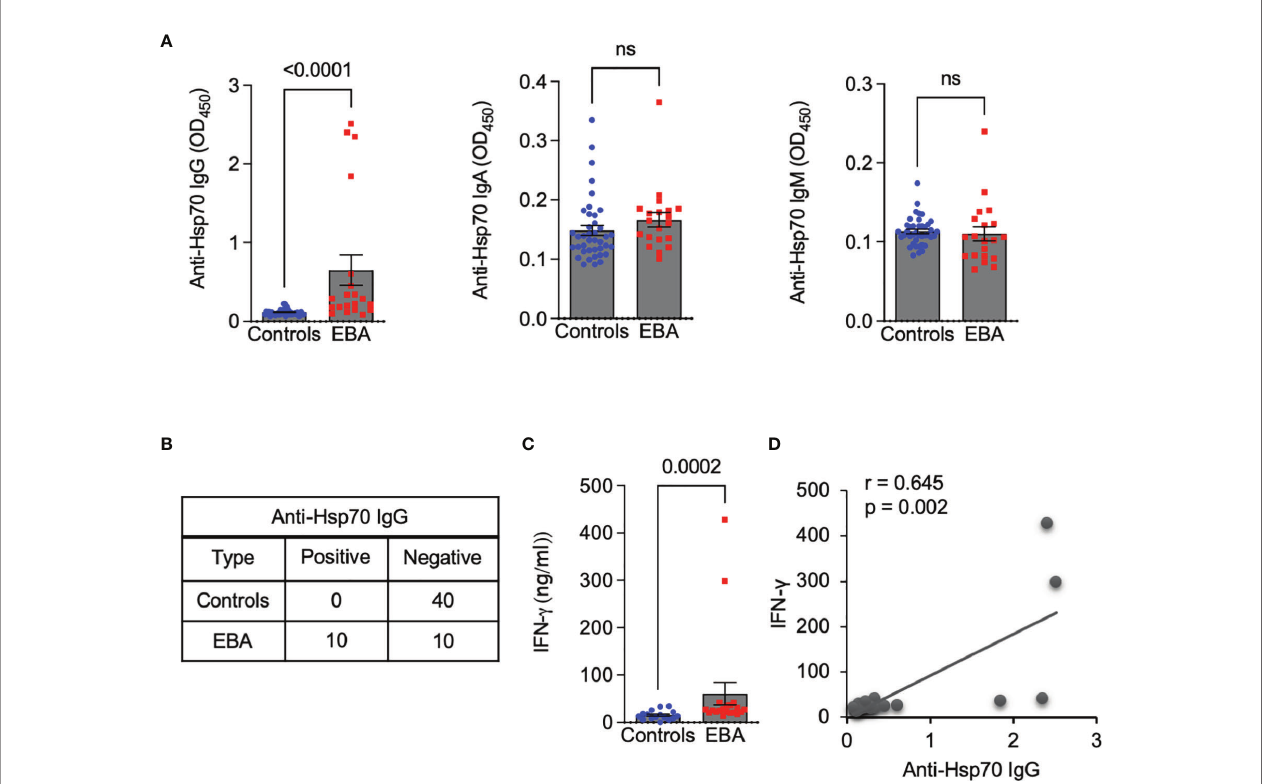
FIGURE 1 | Circulating anti-Hsp70 IgG autoantibodies are elevated in patients with EBA and positively correlated with serum levels of pro-in fl ammatory IFN- g . (A) Levels of anti-Hsp70 IgG, IgA, and IgM autoantibodies in sera of EBA patients (n = 20) and age-matched healthy individuals (n = 40), measured by ELISA. (B) Contingency analysis showing anti-Hsp70 IgG positivity in 50% of EBA patients but not in healthy controls. (C) Levels of IFN- g in sera of EBA patients (n = 20) and healthy controls (n = 16), measured by ELISA. (D) Analysis of a correlation between serum levels of anti-Hsp70 IgG and IFN- g in EBA patients. ns, not signi fi